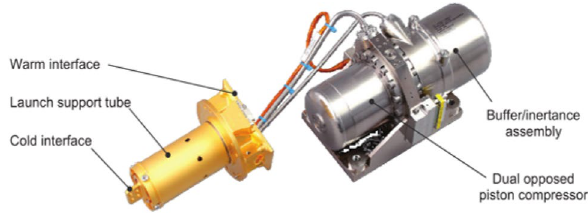
Figure 14. Air liquid pulse tube coolers (LPTC) 35 .